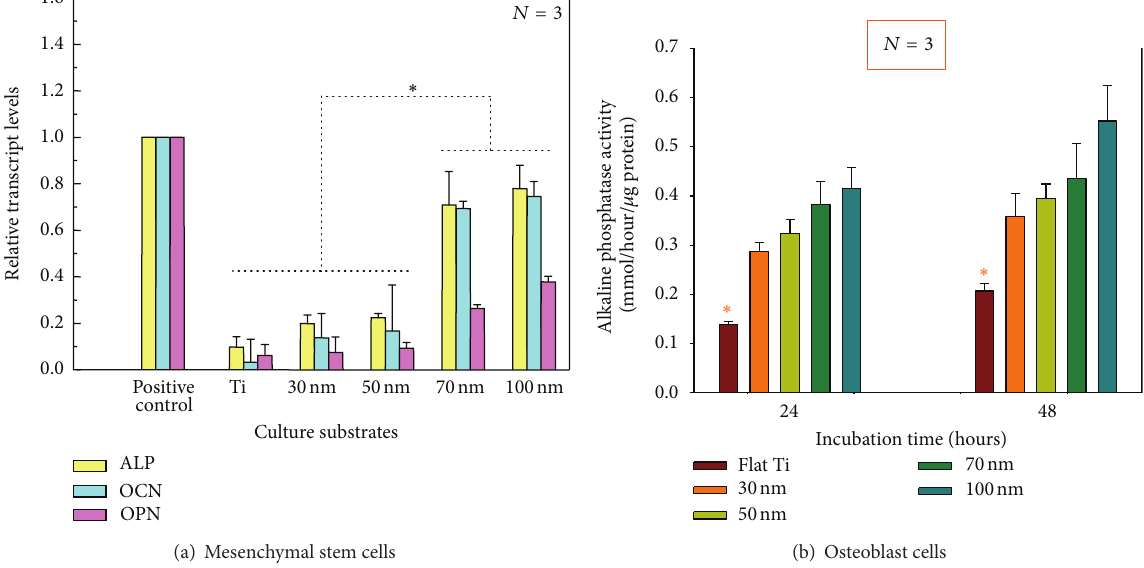
Figure6:ComparativegraphsshowingthetrendofMSCandosteoblastcellfunctionalitywithincreasingnanotubediameter.(a)Quantitative PCR analysis for ALP, OCN, and OPN after 3week mesenchymal stem cell culture. Plastic cell culture plate with osteogenic inducing media was used as a positive control for osteogenic differentiation. (b) ALP activity after 24 and 48 h of osteoblast